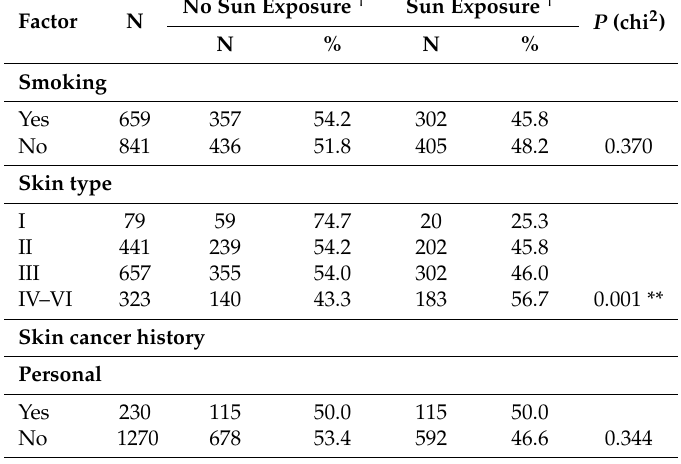
Skin health characteristics of the study population, stratified by sun exposure prevalence